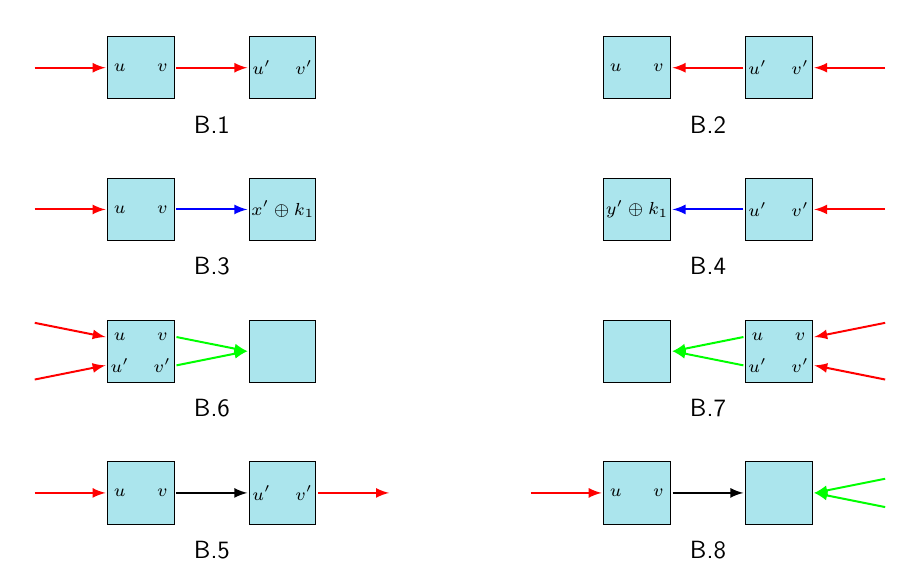
Figure 4.1: Different cases of two-fold collisions. Red edge denotes the input / output collides with prmitive input / output. Blue edge denotes that input collides with the input of some construction query or output of some construction query. Green edge denotes the collision among